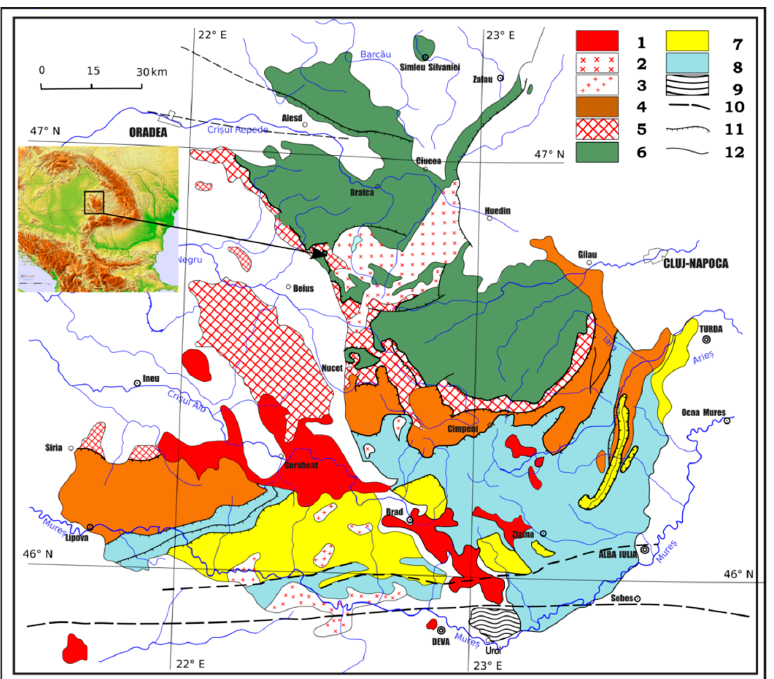
Figure 1. Geological map of Apuseni Mountains compiled and simplified after [10,11] with modifications. Legend: 1 . Miocene-Pliocene magmatic rocks, 2 . Upper Cretaceous-Paleocene Magmatic rocks (Banatites), 3 . Upper Jurassic Granitoids. The North Apuseni Units: 4 . Biharia Nappe Complex, 5 . Codru Nappe Complex, 6 . Bihor Nappe Complex; The South Apuseni Units (Transylvanide): 7 . Upper Jurassic tholeiitic ophiolites and calc-alkaline island arc magmatic rocks and, in places, limestone, 8 . Cretaceous sedimentary rocks, 9 . Supragetic Units, 10 . South Transylvanian Fault system, 11 . Nappes, 12 .